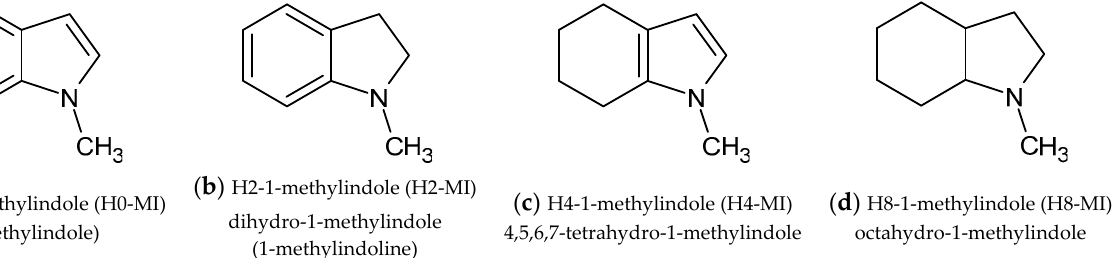
Figure 1. The intermediates identified in the equilibrium mixture of the hydrogenation in the LOHC system 1-methyl-indole/octahydro-1-methyl-indole.